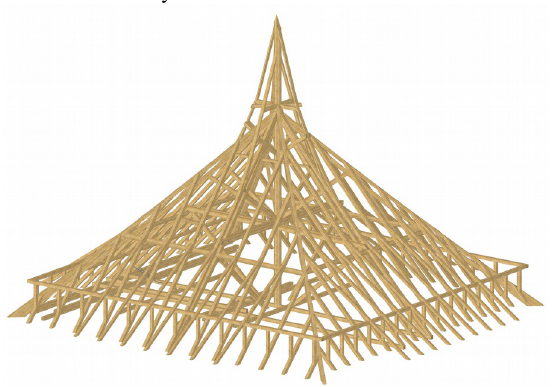
Figure 7. CAD view of the pagoda roof.